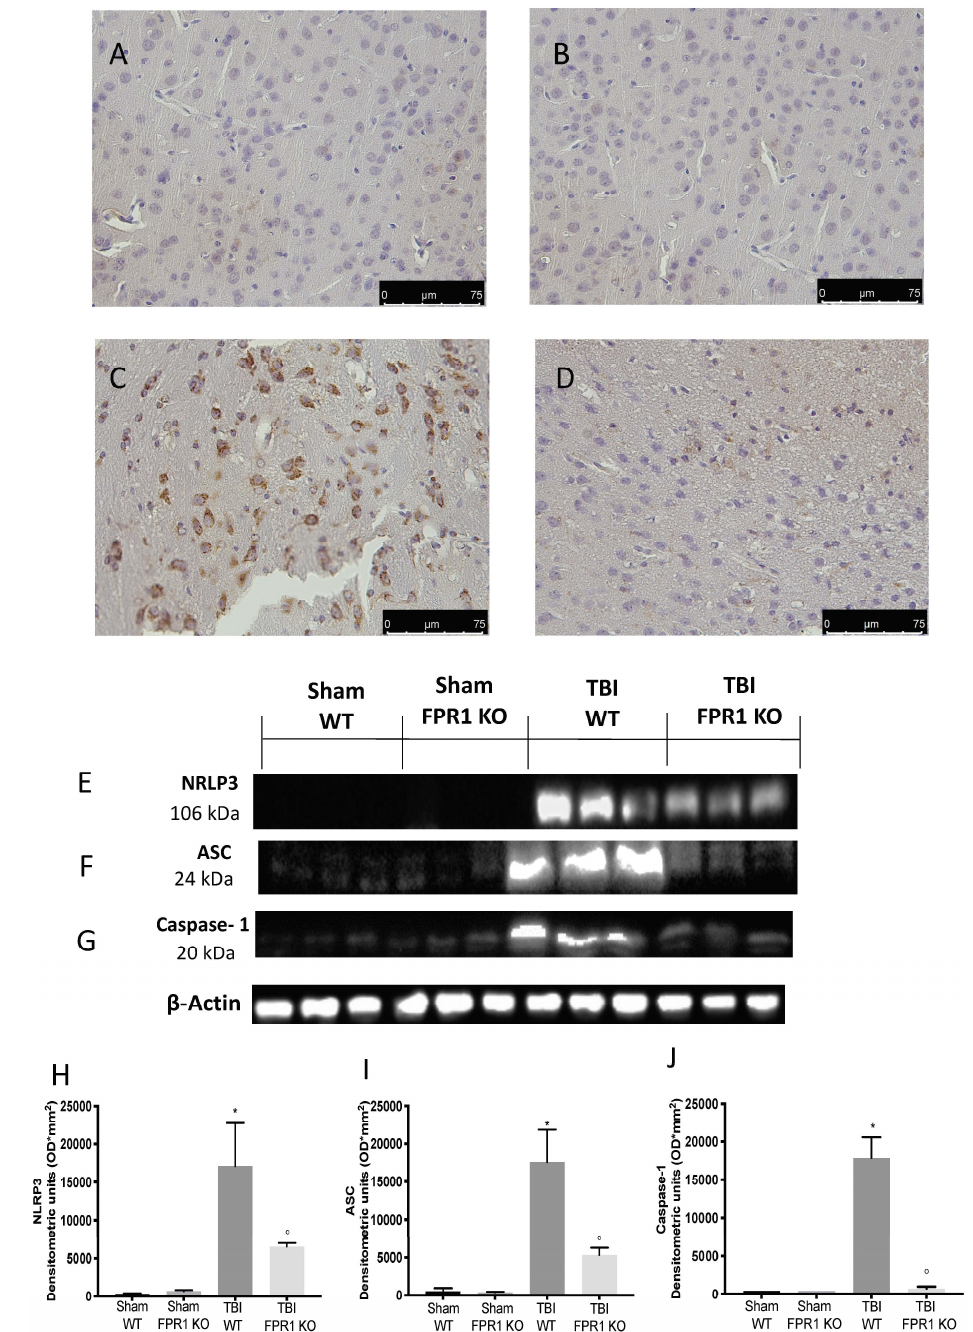
Figure 6. Effect of the absence of Fpr1 on NLRP-3 inflammasome complex activation: Immunohistochemical analysis displays an increased NLRP-3 ( C ) expression in TBI WT mice compared to the Sham WT ( A ) and Fpr1 KO animals ( B ) while TBI Fpr1 KO animals do not show any increase ( D ) Western blot analysis confirms the upregulation of NLRP3 expression ( E ) ASC ( F ) and Caspase-1 ( G ) in the TBI WT group 24 h after injury, compared to the Sham WT and Sham Fpr1 KO group. Fpr1 KO animals 24 h after TBI show reduced levels of NLRP3, ASC and Caspase-1 compare to the TBI WT group; see the densitometric analysis ( H – J , respectively). For the analyses, n = 5 animals from each group were employed. Results were analyzed by two-way ANOVA followed by a Bonferroni post-hoc test for multiple comparisons. Non-parametric data were analyzed with Fisher’s exact test. * p < 0.05 vs. Sham WT; ◦ p < 0.05 vs. TBI WT. scale bar 75 µ